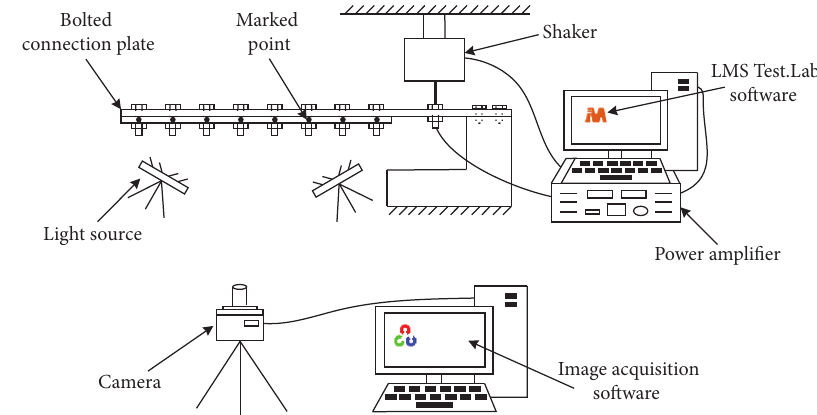
Figure 2: The sketch of the detecting system of bolt looseness.